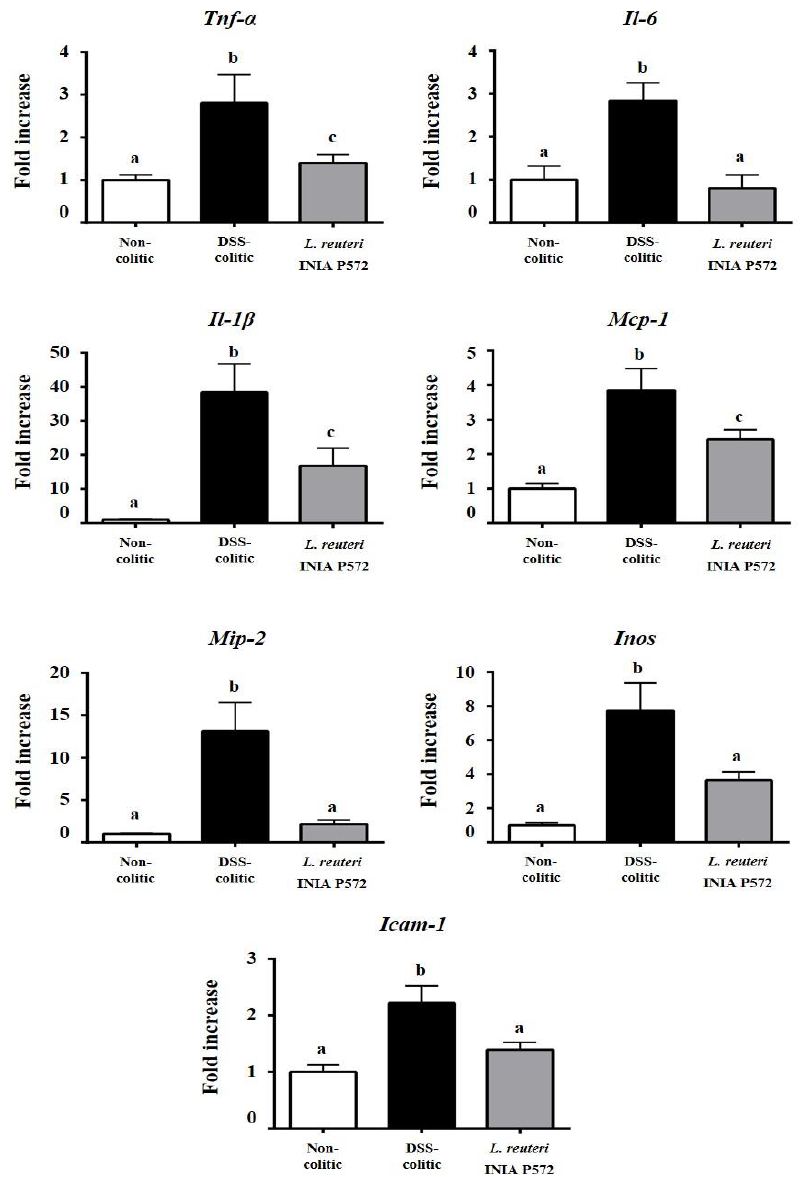
Figure 5. Effects of L. reuteri INIA P572 on colonic gene expression of TNF- α , IL-6, IL-1 β , monocyte chemotactic protein-1 (Mcp-1), macrophage inflammatory protein 2 (Mip-2), Inducible enzyme nitric oxide synthase (Inos), and intracellular adhesion molecule-1 (Icam-1) in DSS-colitic mice, analyzed by real-time qPCR. Data are expressed as mean ± SEM ( n = 10). Groups with different letters statistically differ ( p <